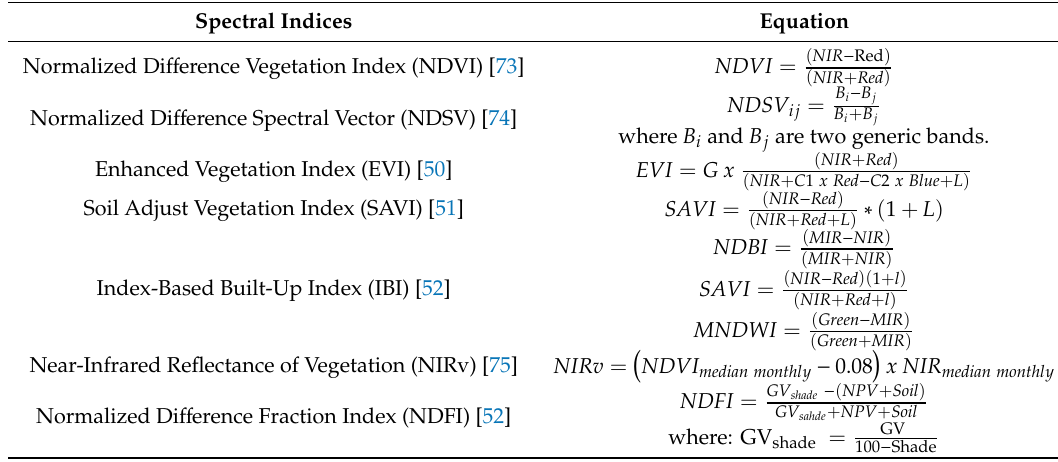
Table A1. Spectral indices used for forest degradation mapping. Spectral Indices